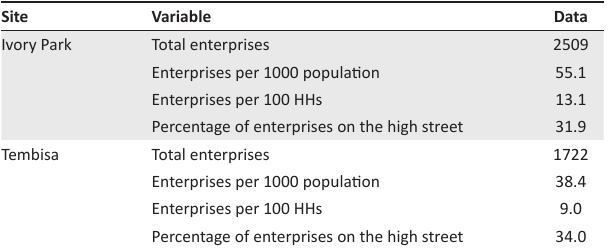
TABLE 2: Summary of enterprise census results.